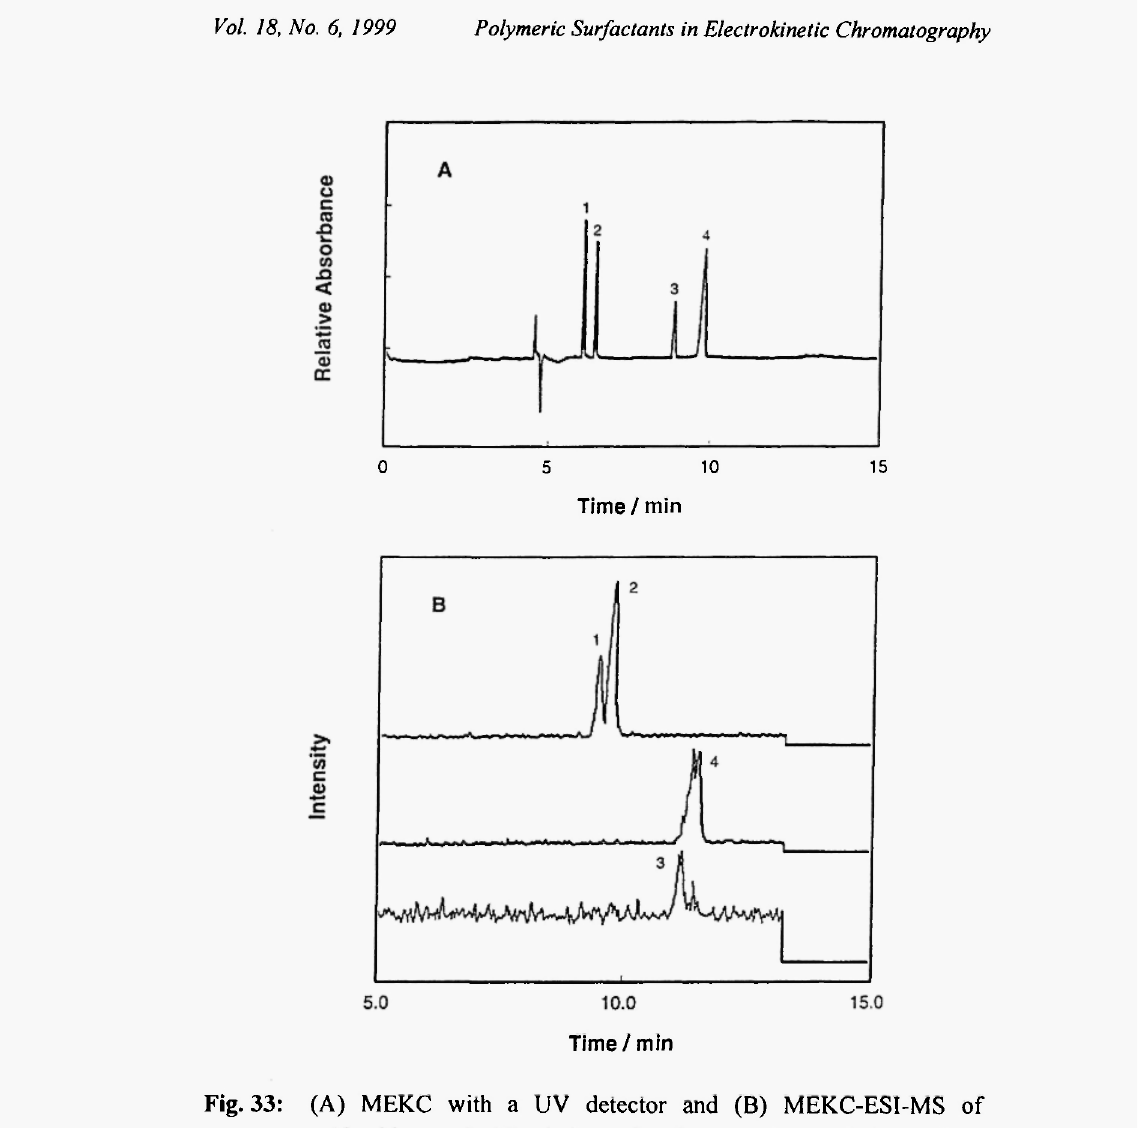
Fig. 33: (A) MEKC with a UV detector and (B) MEKC-ESI-MS of sulfamides and (C) their molecular structures. Solutes: 1 = sulfamethazine; 2 = sulfisomidine; 3 = sulfadiazine; 4 = sul- fisoxazole. Conditions: (A) separation solution, 1 % BBMA in 10 % methanol and 100 mM borate-50 mM phosphate buffer (pH 7); capillary, 48 cm (40 cm to the detector) χ 50 μπι I.D. fused silica; applied voltage, 20 kV; detection wavelength, 210 nm. (B) Other conditions as in Figure 32 except for the interface; the MS instrument was operated in the SIM mode. From /81/ with